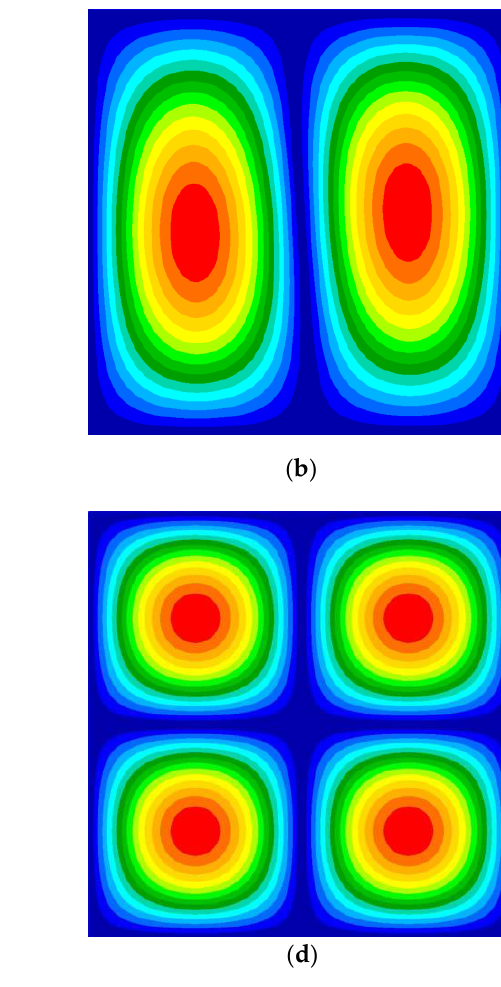
Figure 16. In Figure 16a, the artificial damping coefficients c 2 , c 3 , c 4 and c 5 are all realized by setting a linear damper between the damping configuration point and a boundary point.